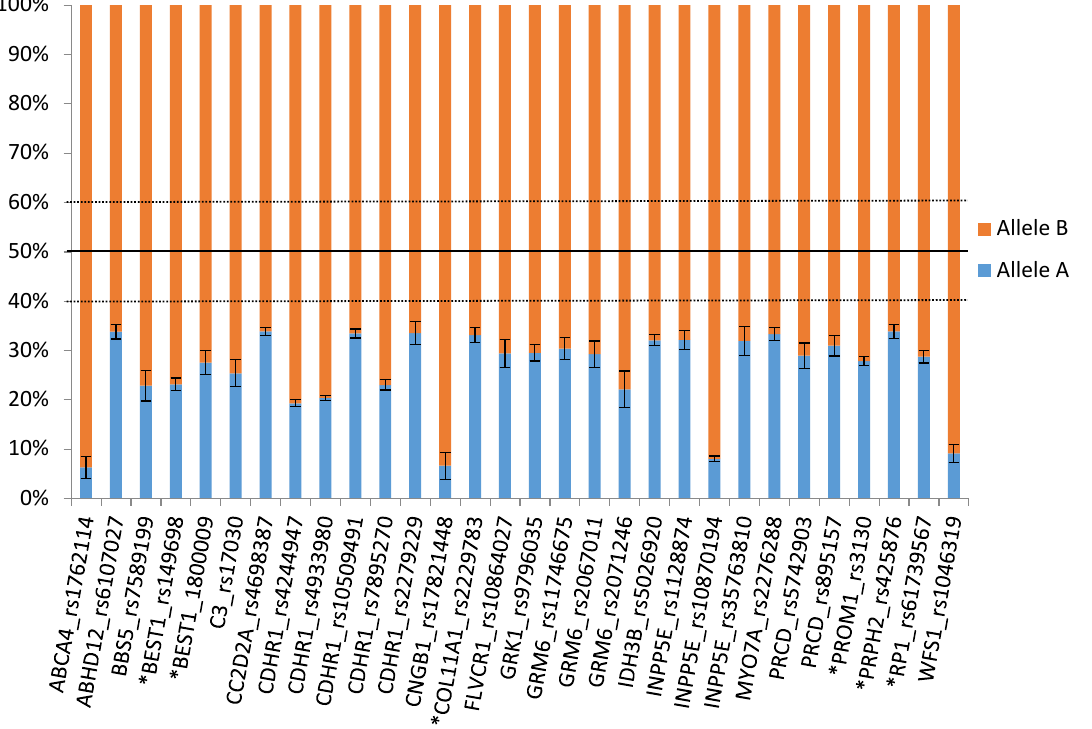
Figure 2. Representation of the relative allelic percentage (mean ± standard error of the mean or SEM). Shown are those SNPs in inherited retinal diseases (IRD) genes displaying allelic expression imbalance (AEI) frequencies higher than 10% in the 52 RNA-seq sample-set. Genes associated with autosomal dominant inherited IRDs are marked with an asterisk. Allelic balance is delimited within the 40–60% range.